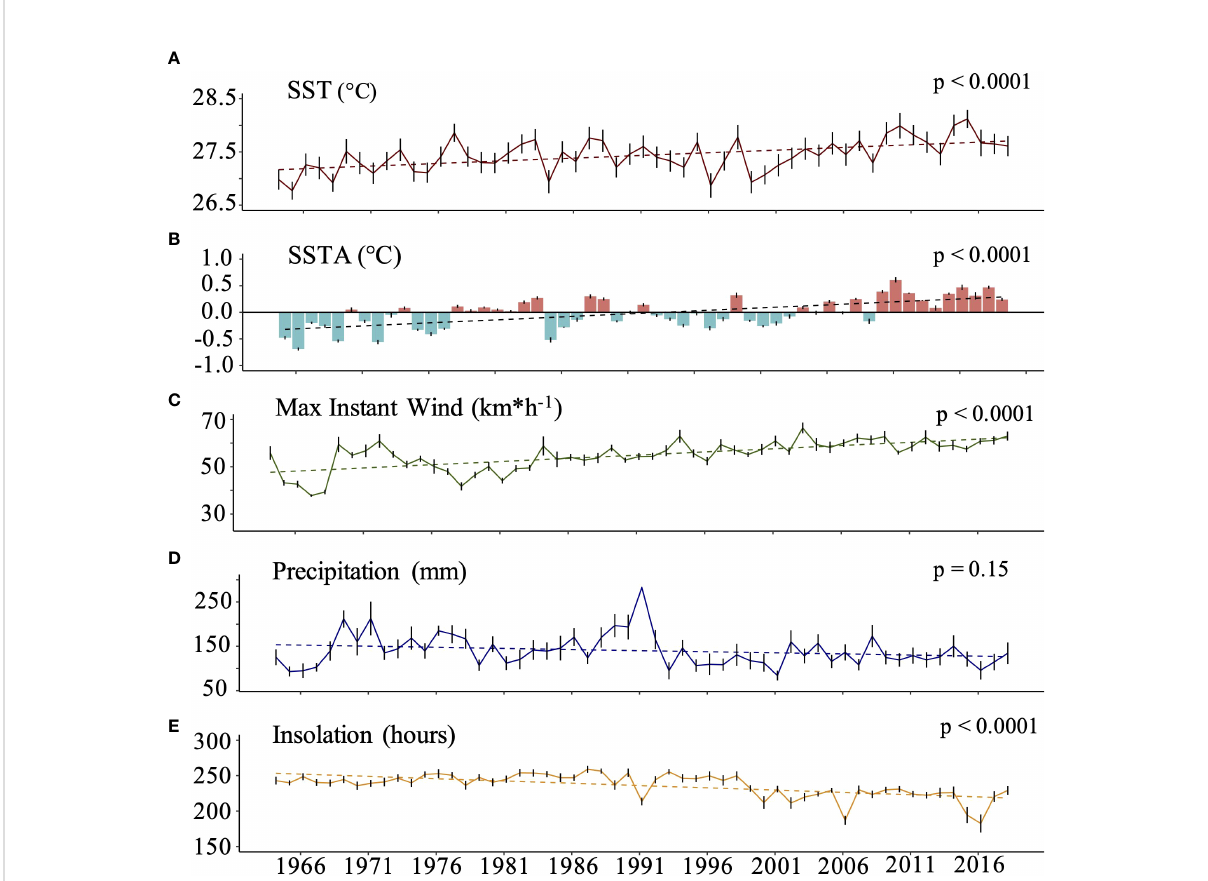
FIGURE 4 Interannual variability of the different environmental parameters at Mayotte between 1964 and 2018. (A) . Sea Surface Temperature (SST in °C) (B) Sea surface temperature anomalies (SSTA in °C). (C) Maximum instantaneous wind speed (km*h -1 ). (D) Precipitation rate (mm). (E) Annual cumulative insolation period (hours). Errors bars (SE) for each variable were calculated after averaging monthly